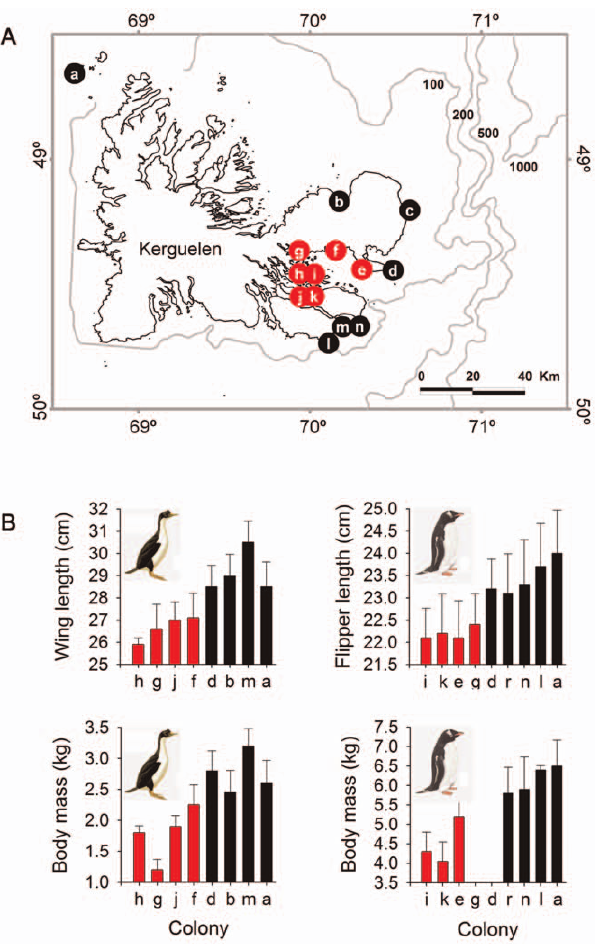
Figure 2. Geographic micro-variability of body size in the Kerguelen Shag and Kerguelen Gentoo Penguin. (A) Position of colonies at Kerguelen where measurements were performed on Kerguelen Shags and Gentoo Penguins. Colonies in red are inside a shallow and closed sea (the Golfe du Morbihan) and colonies in black are facing the open ocean. (B) Average body mass ( 6 SD) and average wing/flipper length ( 6 SD) of Kerguelen Shags (left) and Gentoo Penguins (right) at these colonies. Redrawn after [39].